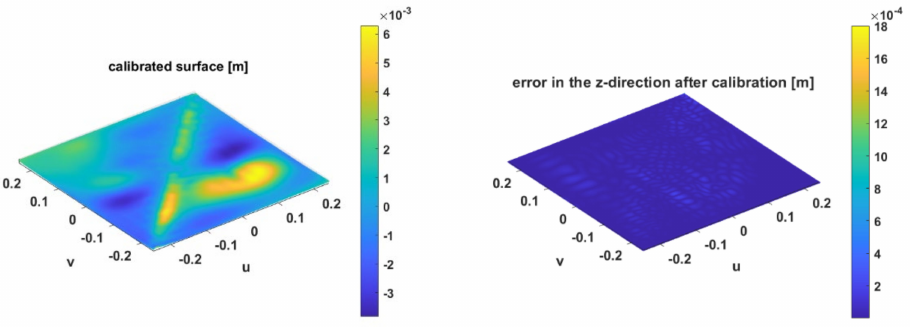
Figure 9. Left: artefacts coming from 3D printing; right: the point-wise error after calibration. The obtained surface was finally subtracted from each approximated point cloud in order to enable a comparison with the unnoisy mathematical reference surface. The point-wise error in the z direction after calibration and re-approximation of the calibrated point cloud is shown in Figure 9 (right). It highlights the goodness of the calibration: no outliers or spurious patterns can be seen, and the null hypothesis that the point-wise error term should correspond to white noise could not be rejected with a confidence level of 5% using the Lilliefors test